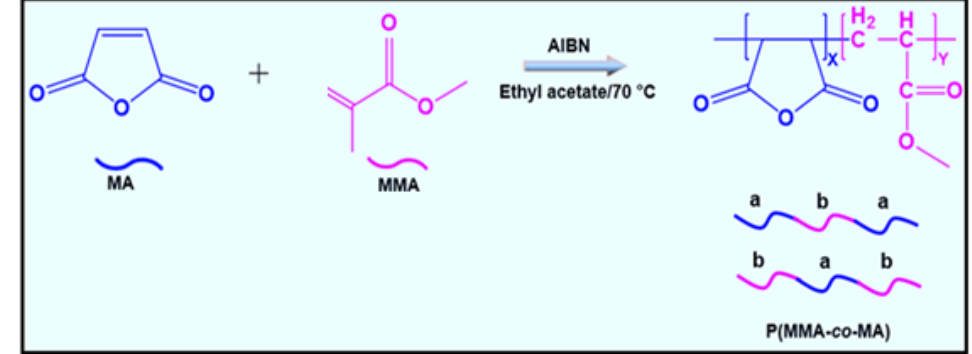
Figure 1. Synthetic routes of poly(methyl methacrylate-co-maleic anhydride) copolymer.